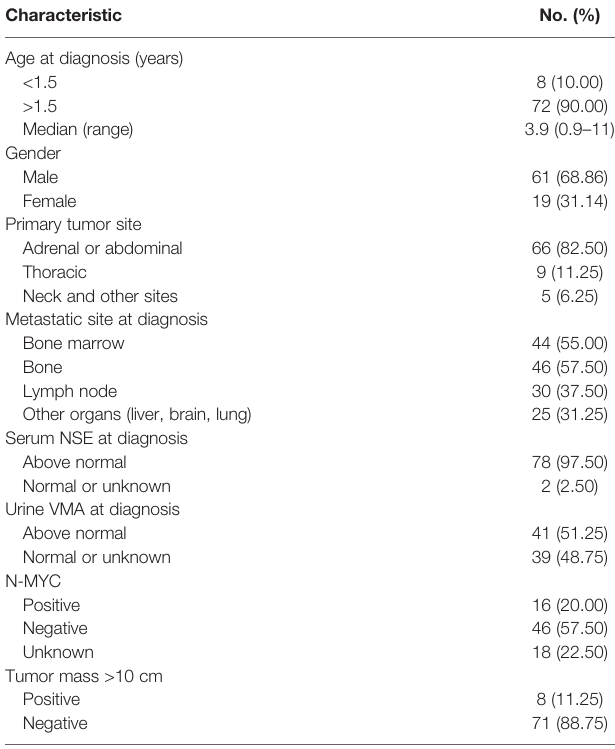
TABLE 2 | Patient characteristics of study cohort. Characteristic